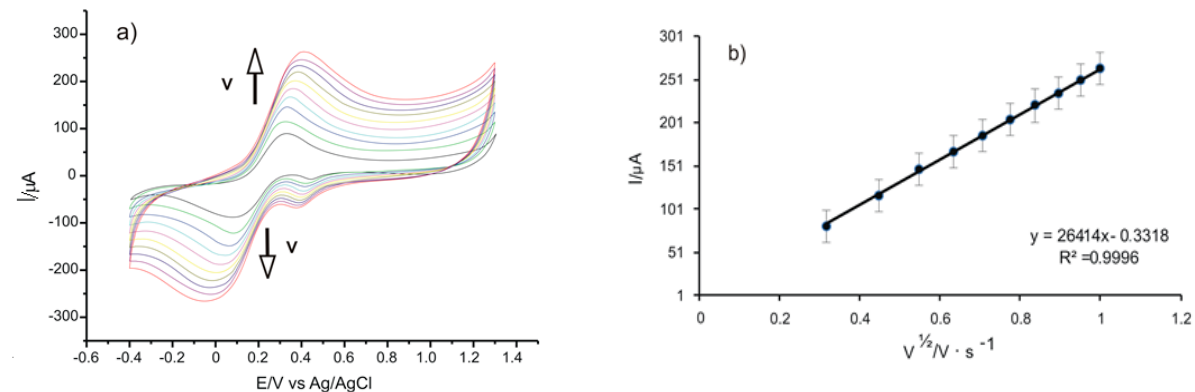
Figure 3. ( a ) CVs of GPH-GNP-SPE immersed in 10 − 3 M K 4 [Fe(CN) 6 ]–10 − 1 M PBS solution registered with scan rates in the range of 0.1–1.0 V · s − 1 . ( b ) Plot of the linear dependence between the anodic peak current and the scan rates.